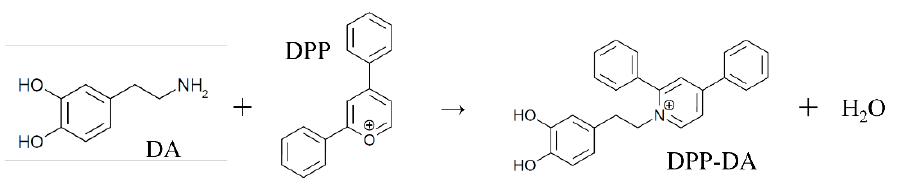
Figure 1. Chemical reaction of DPP-derivatization. DA, Dopamine; DPP, Tetrafluoroborate salt of 2,4-diphenyl-pyranylium.